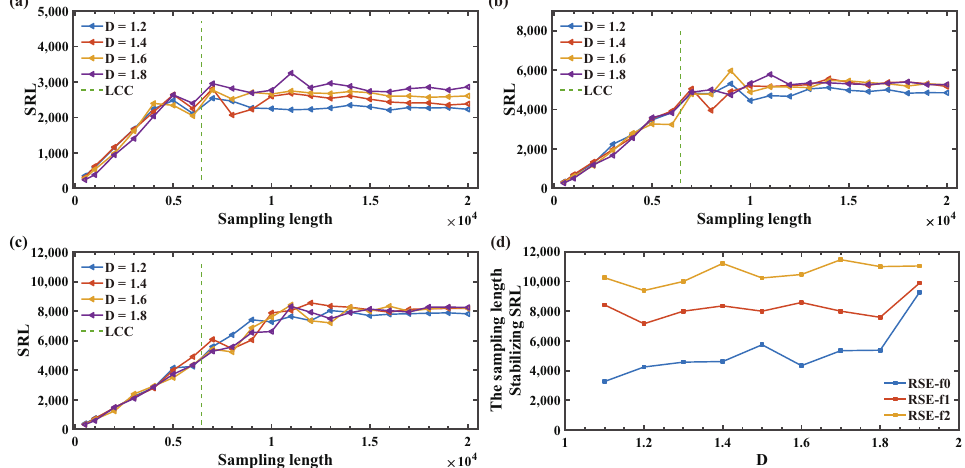
Figure 10. The relationships between scaling region length (SRL) and the sampling length under the flattening order of: ( a ) 0, ( b ) 1, ( c ) 2. ( d ) The influence of flattening orders on the sampling length that could stabilize